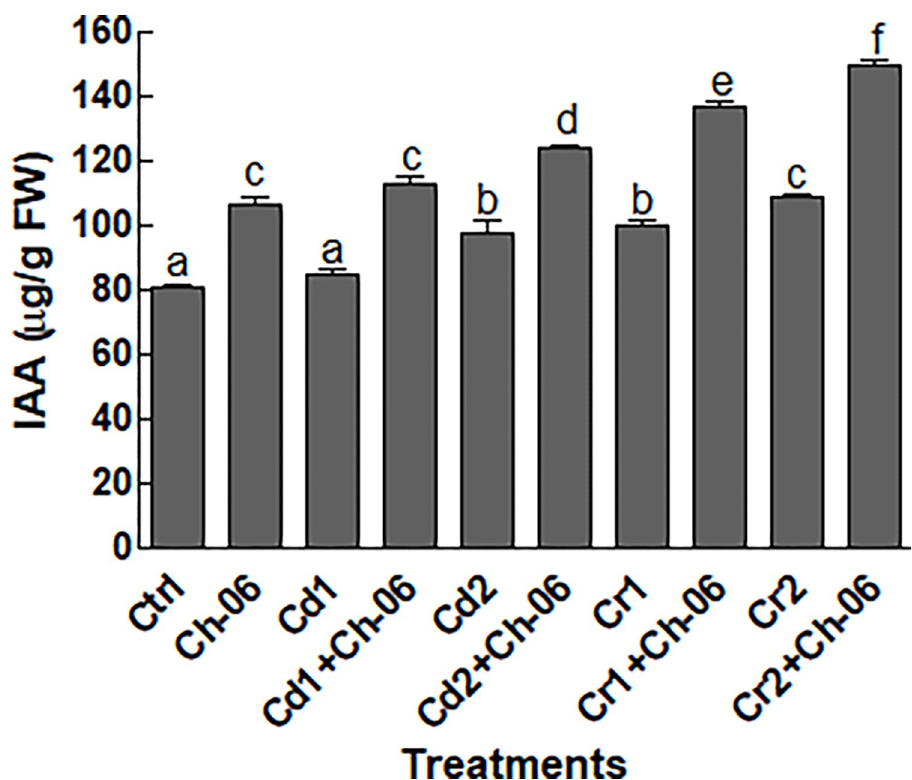
Fig 7. Impact of Ch-06 ( A . violaceofuscus ) on proline, flavonoids and phenolic contents of okra under elevated Cd and Cr stress. Co: Control, Cd = cadmium, Cr = chromium, Cd1 and Cr1 = 100 μ g/g, Cd2 and Cr2 = 500 μ g/g. (A): Proline, (B): Flavonoids, (C): Phenolics. The data reflect the mean of triplicated data followed by ± SE. The data with different superscript letter are significantly different at P = 0.05.